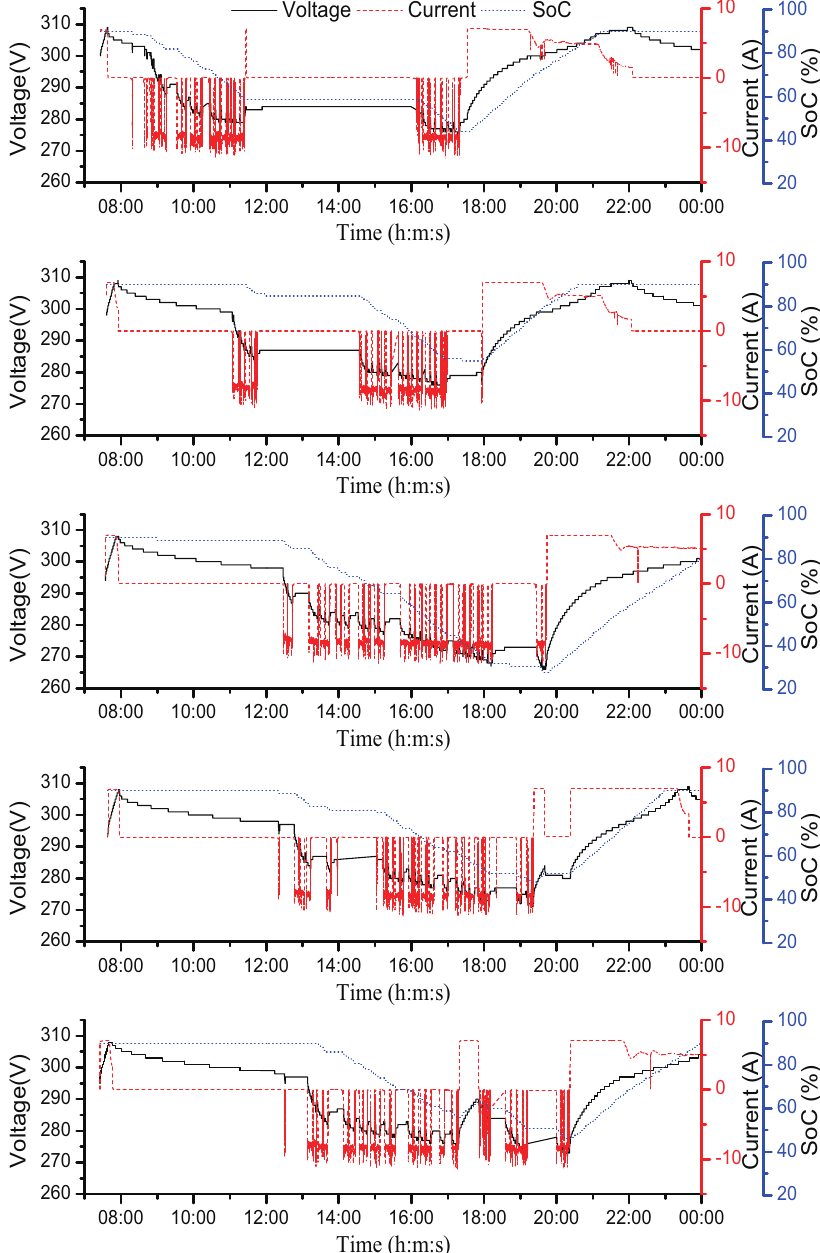
Figure 13. The operation condition of electric boat continuously for five days (From top to bottom, it is the operation condition of electric boat from first day to the fifth